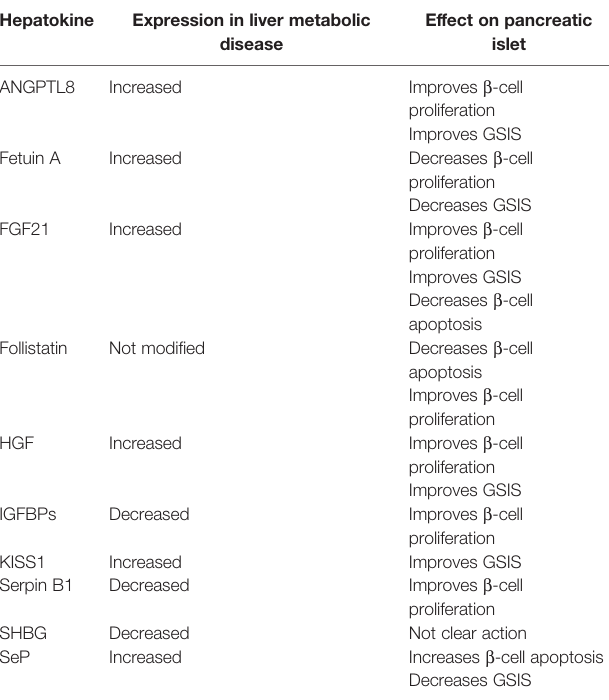
TABLE 1 | Hepatokines released by fatty liver and their role in liver and pancreatic islet crosstalk.